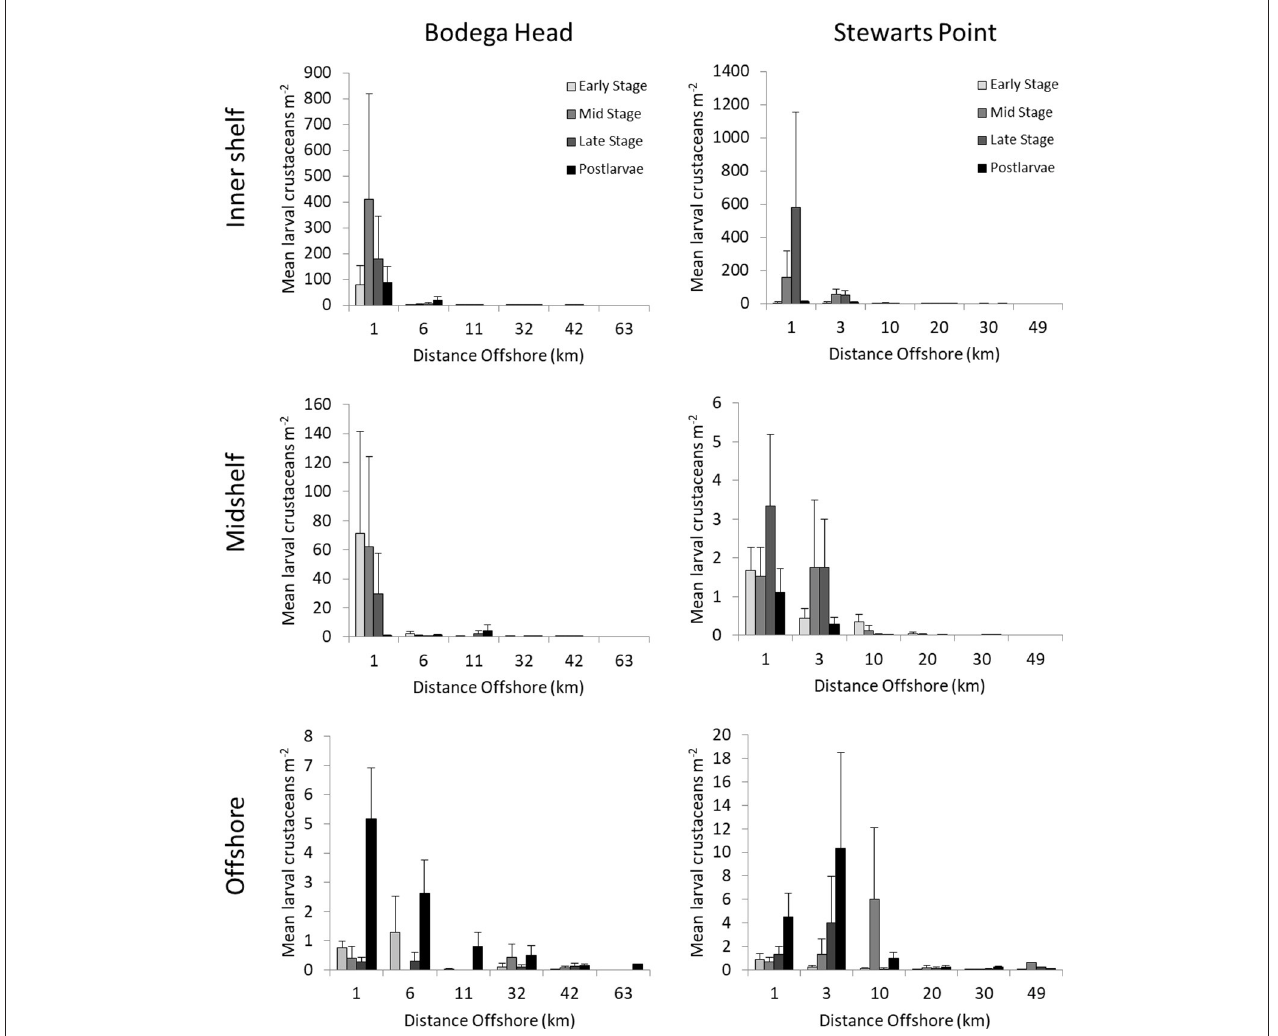
FIGURE 6 | Densities (mean/m 2 + 1 SE) of larval stages of 42 species of benthic crustaceans relative to distance from shore for all depths and cruises combined at Bodega Head and Stewarts Point on 28–29 May, 24–25 June, and 14–15 July. Twenty-two species largely remained on the inner shelf off Bodega Head ( < 11km from shore) and Stewarts Point ( < 10km from shore) throughout development. Four species primarily occurred on the inner shelf and ranged across the midshelf late in development off Bodega Head ( < 32km from shore) and Stewarts Point ( < 30km from shore). Sixteen species primarily occurred on the inner shelf and ranged offshore late in development off Bodega Head ( > 32km) and Stewarts Point ( > 30km). Note scale changes.